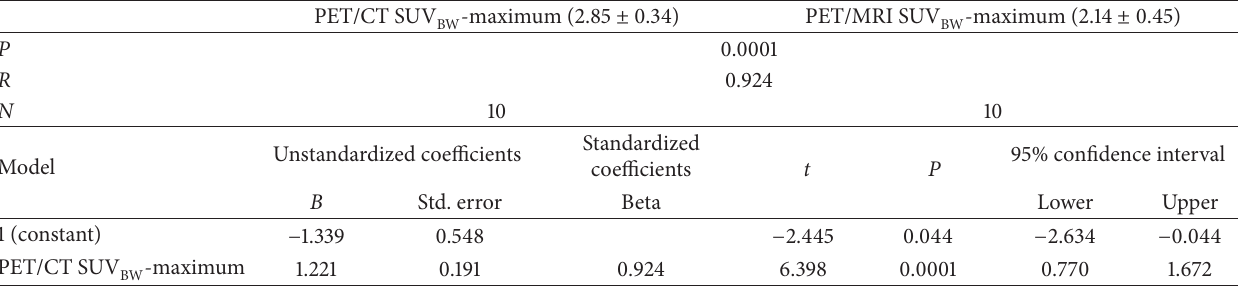
-maximum and PET/MRI SUV BW